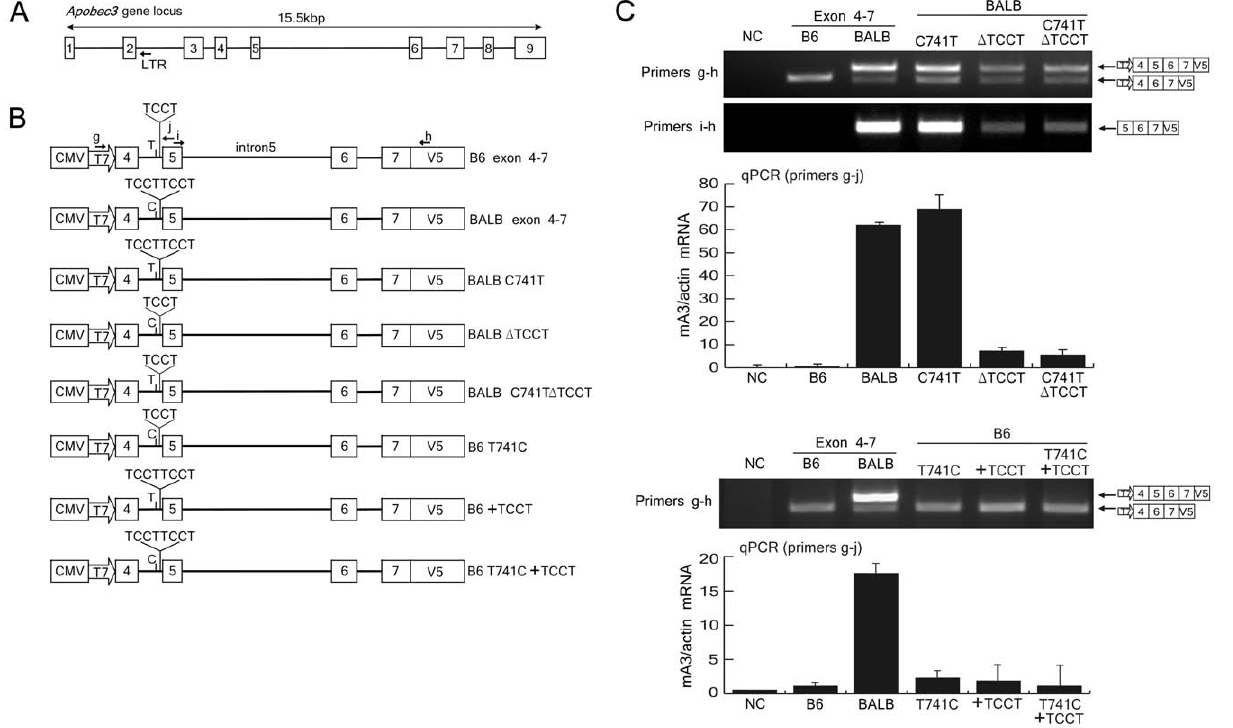
Figure 4. The impact of TCCT repeat numbers on exon 5 inclusion in mA3 mRNA splicing. (A) Schematic representation of the genomic DNA structure of the Apobec3 gene locus. Boxes indicate exons. LTR, the endogenous retroviral LTR inserted into intron 2 in some strains of mice [37]. (B) Insert structures of the plasmids used for the splicing assays. BALB/c exon 4–7 and BALB/c D TCCT plasmids harbored the same DNA fragment amplified from BALB/c genomic DNA encompassing exons 4 and 7, except that the BALB/c D TCCT contains only a single TCCT quadruplet. B6 exon 4– 7 plasmid harbored the B6 genomic DNA fragment encompassing exons 4 and 7. C741T and T741C indicate a C to T or reciprocal nucleotide substitution, respectively, within intron 4 at 741-bp downstream from the first nucleotide of exon 4 on the backbone of the BALB/c or B6 exon 4–7 insert. An additional repeat of the TCCT quadruplet was added to the B6 exon 4–6 construct to generate B6 + TCCT. The positions of primers g, h, i, and j used for RT-PCR assays are indicated with the arrows. (C) The plasmid harboring each insert depicted in (B) was transfected into BALB/3T3 cells, total RNA was extracted, and RT-PCR reactions were performed with primer pairs g–h and i–h. A portion of the transfected cells were utilized for luciferase assays to compare transfection efficiencies among the samples. Comparable levels of luciferase activities were observed in all samples in each experiment (data not shown). The predicted splicing products are schematically indicated on the right side of the panel. Quantitative real-time PCR assays were performed with primers g and j, and data are shown here by averages of three reaction wells and